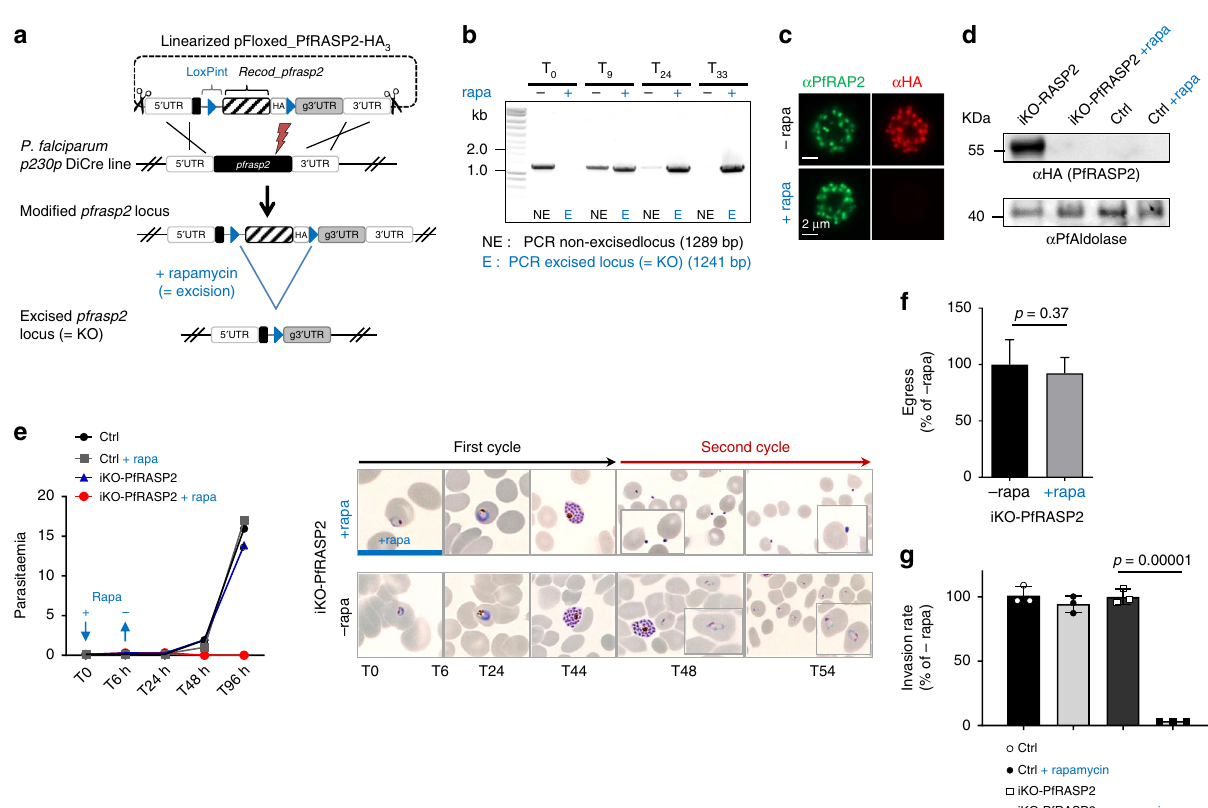
Fig. 5 P. falciparum RASP2 is necessary for invasion. a Strategy for conditional excision of the pfrasp2 gene using the DiCre system. b PCRs showing ef fi cient excision of the pfrasp2 locus upon addition of rapamycin with primers 3181/2911 (non-excised), 3181/2912 (excised). c IFA on iKO-PfRASP2-HA 3 schizonts ± rapamycin. d Immunoblot on schizont lysates from the p230p DiCre (parental line) and iKO-PfRASP2 mutant line ± rapamycin. PfAldolase, loading control. e Left: Growth curves (parasitaemias) of p230p DiCre (Ctrl) and iKO-PfRASP2 mutant ± rapamycin shows that PfRASP2-depleted parasites are unable to proliferate. Right: Giemsa stainings illustrating the development and reinvasion of iKO-PfRASP2 merozoites (48 h) in the absence of rapamycin and their accumulation at the surface of RBCs in the presence of rapamycin treatment. f Graphical summary of egress data of control (-rapa) and rapamycin-treated iKO-PfRASP2 schizonts following removal of C2. Data collected from 8 control movies (-rapa) and 11 movies in the presence of rapamycin. Number of egress events normalized as a percentage of control (-rapa) considered as 100% egress here. g Invasion rate of Ctrl and iKO- PfRASP2 parasites treated ± rapamycin. Synchronized cultures were treated for 6 h at ring stage with rapamycin or DMSO and were quanti fi ed by fl ow cytometry (100,000 RBCs were analysed for each time point) over 2 cycles (see methods). (e, g) Values represent means± SD ( n = 3) from a representative experiment out of two independent assays. Source data are provided as a Source Data fi